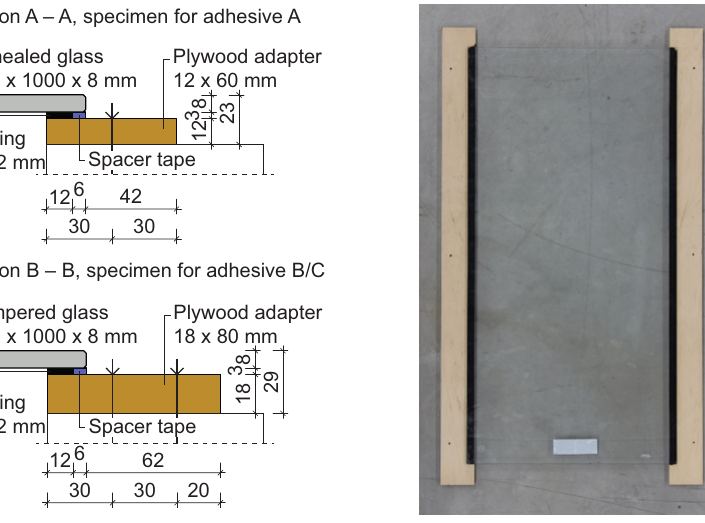
Fig. 2 Specimen configuration for mid-size shear tests